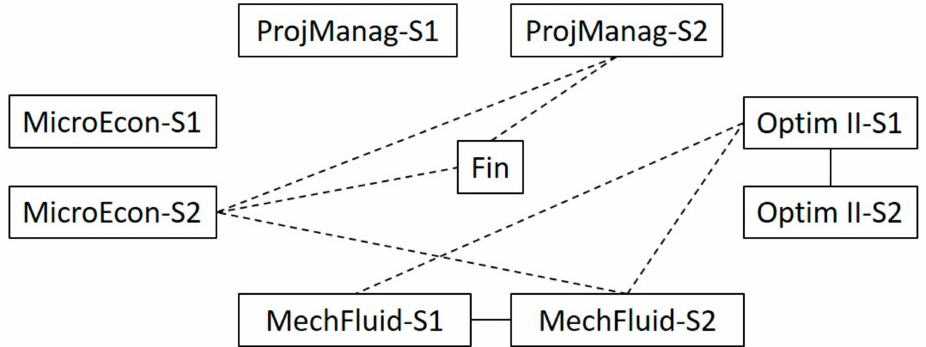
Figure 3. Conflicts between course-sections when set of constraints (7) is not considered in our model (dotted lines) produced an unbalanced schedule. This situation leads to sections with only few students while other sections concentrate most of the students. The conflicts when set of constraints (7) is considered (solid lines) produced a more balanced